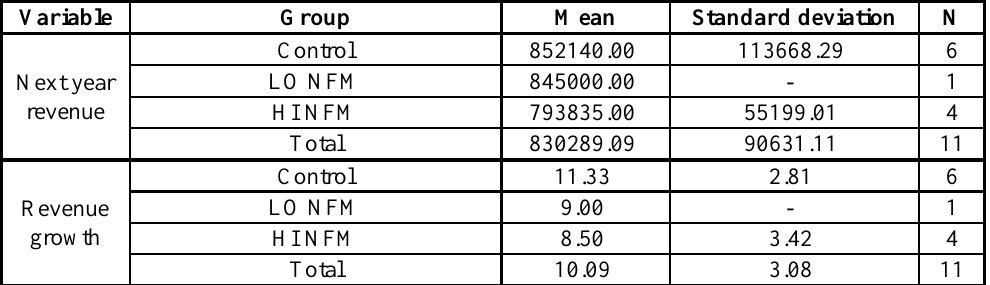
Table 4. Descriptive statistics (non-financial information alone and high